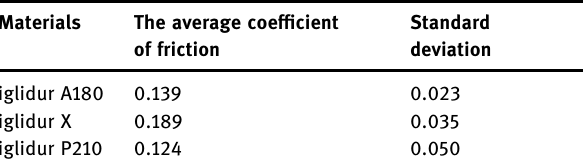
Table 2: Summary of the values of the coe ffi cients of friction of the tested materials Materials